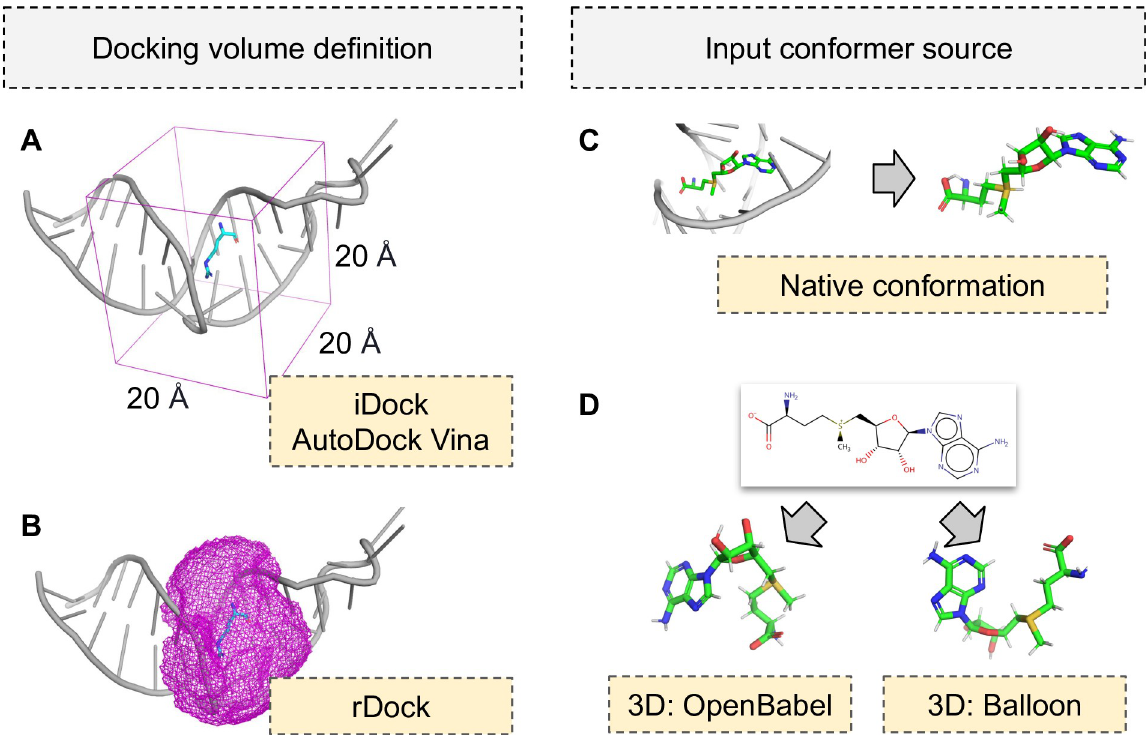
Fig 12. Docking volume definitions for docking programs (left) and input conformer sources used for docking (right). For AutoDock Vina and iDock a box of sizes 20 Å × 20 Å × 20 Å was set, with a center in the center of mass of the ligand (pane A), while for the rDock it is defined as a volume around the known ligand at the maximum distance 10 Å from the ligand atoms (pane B). Three sources of ligand conformers were tested in docking: native pose extracted from the experimentally determined structure (pane C) and conformations generated de novo by two programs: OpenBabel and Balloon (pane